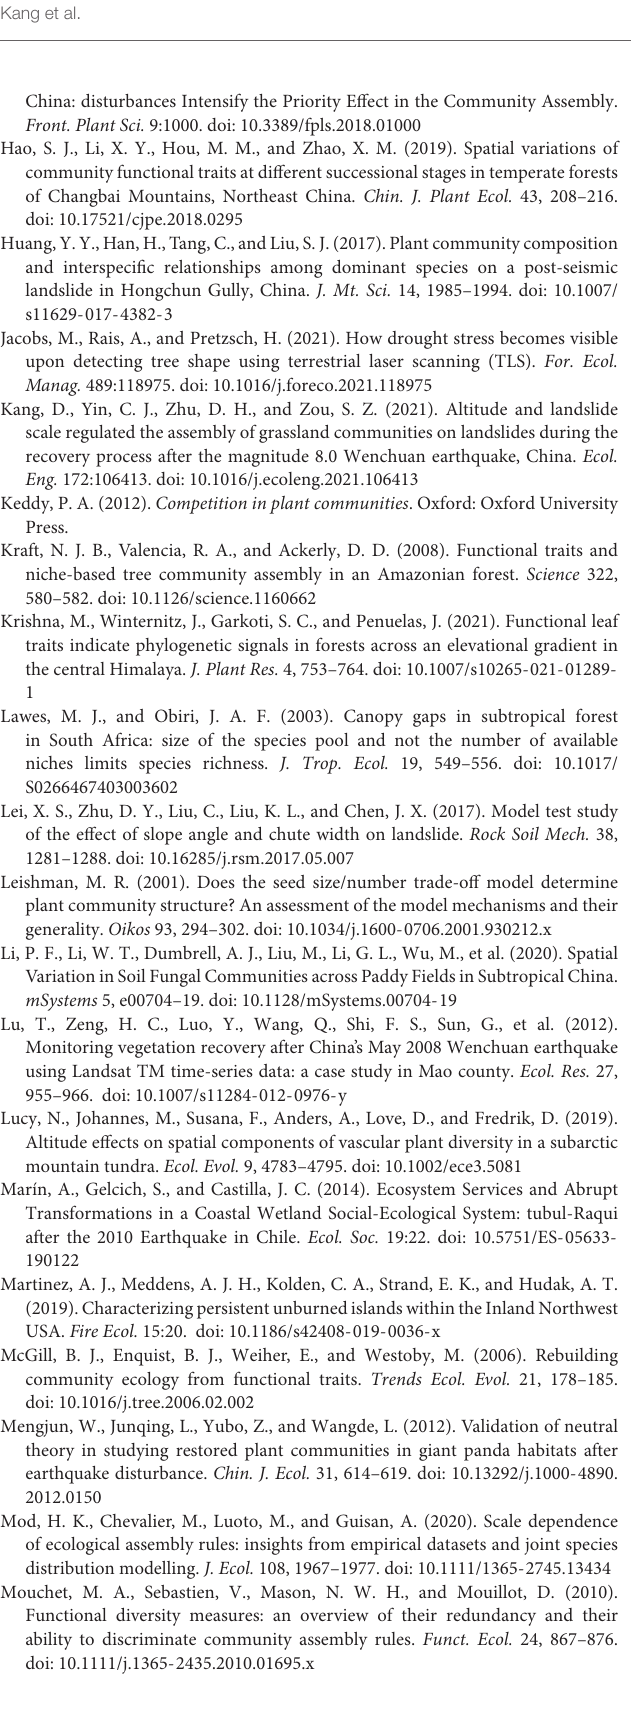
Frontiers in Ecology and Evolution |